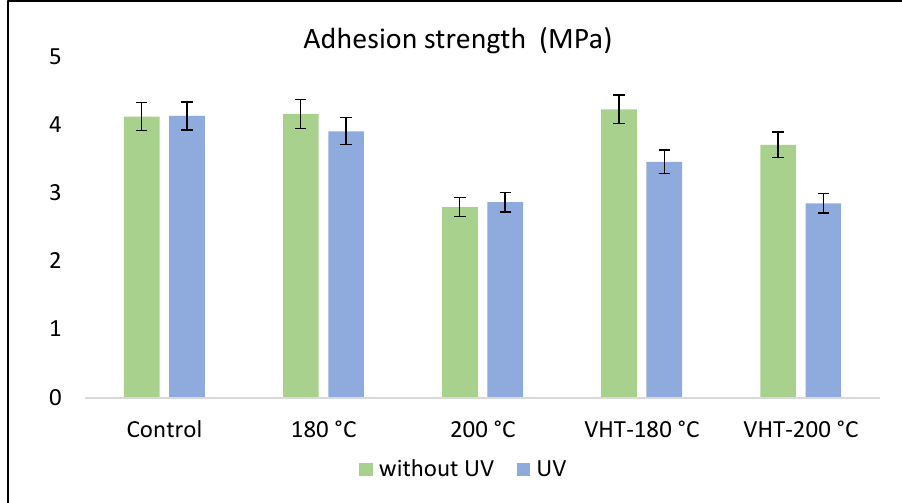
Figure 2. Average adhesion strength values of modified poplar wood samples.